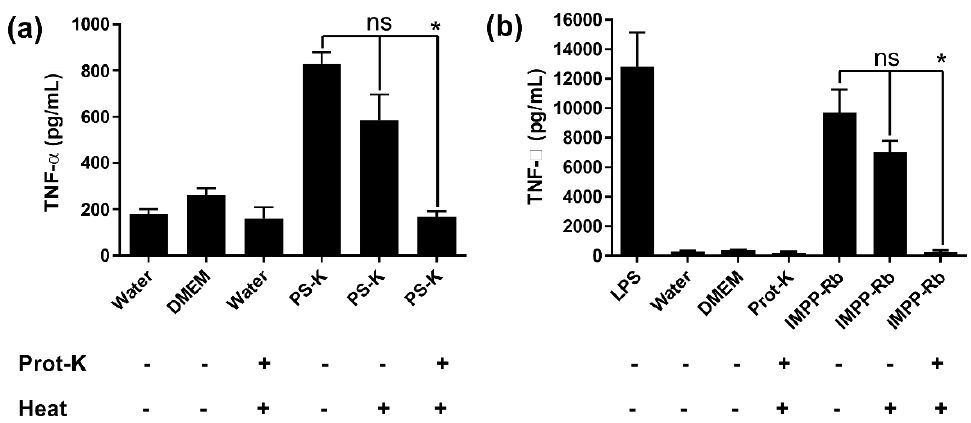
Figure 6. Effect of proteinase-K on immunomodulatory activity of polysaccharides. ( a ) PS-K (0.2 mg/mL) and ( b ) IMPP-Rb (1.5 mg/mL) were treated with 1 mg/mL proteinase-K. Samples were then heated at 80 °C for 20 min before being added to RAW264.7 cells. Results shown are mean ± SD from three independent experiments. One-way ANOVA (Tukey test) was used for statistical analysis. ns = not significant. * p < 0.05.